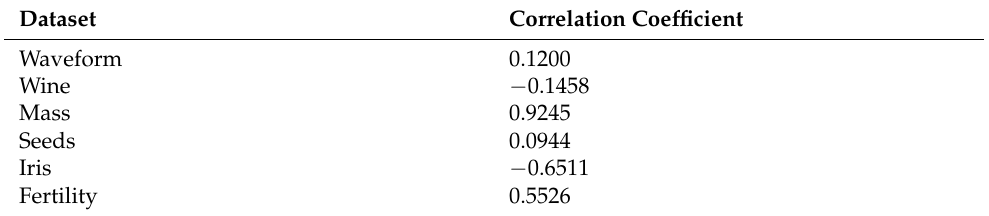
Table 6. The correlation coefficient between dependencies and weights in each numerical